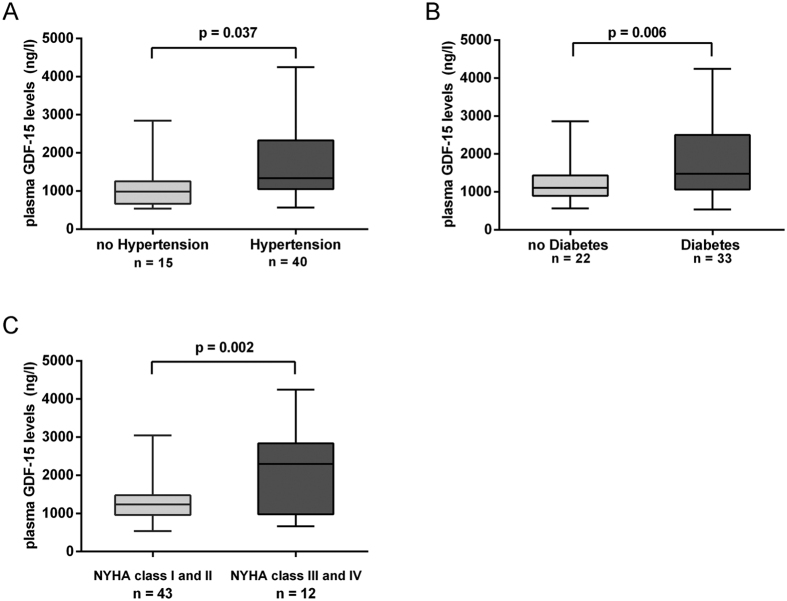
Association of pre-SURG circulating GDF-15 levels with clinical variables.GDF-15 levels were significantly related to the (A) hypertension (1600.8 ± 830.9 ng/l vs. 1097.6 ± 590.3 ng/l, p = 0.037) and (B) diabetes (1668 ± 269.1 ng/l vs. 1379 ± 123.5 ng/l, P = 0.006). Patients in NYHA functional class III or IV heart failure showed a significantly higher GDF-15 levels (2032.0 ± 1108.0 vs 1305.0 ± 619.0 ng/l, P = 0.002) as compared to those patients in NYHA functional class I and II (C) (Student’s test).